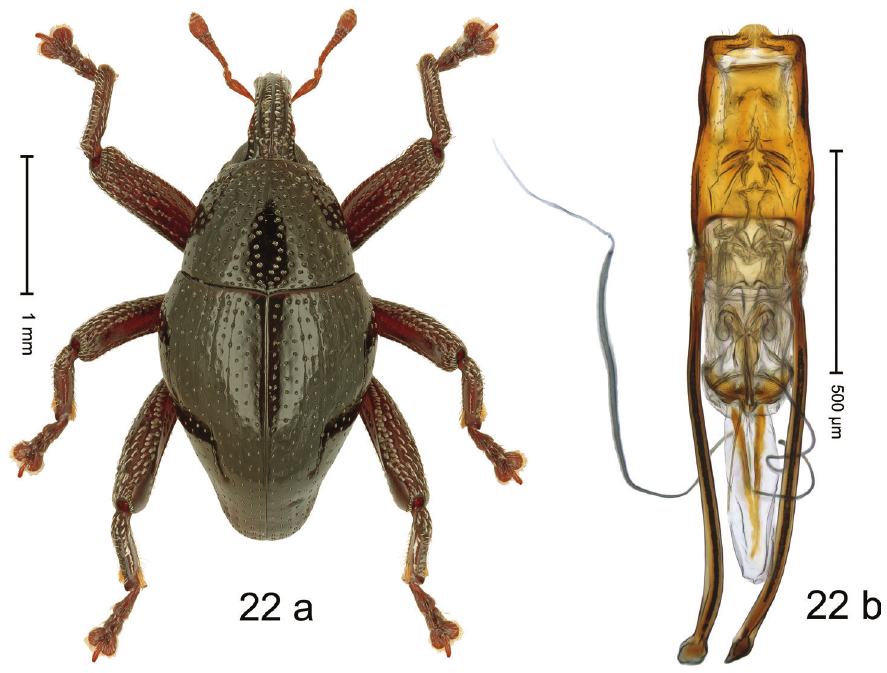
Figure 22. Trigonopterus sutrisnoi sp. nov., holotype a habitus b penis.